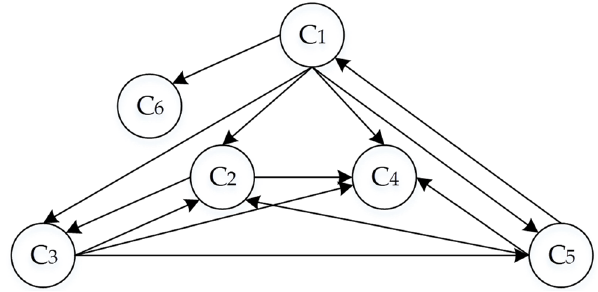
Figure 15. A case node conflict network.